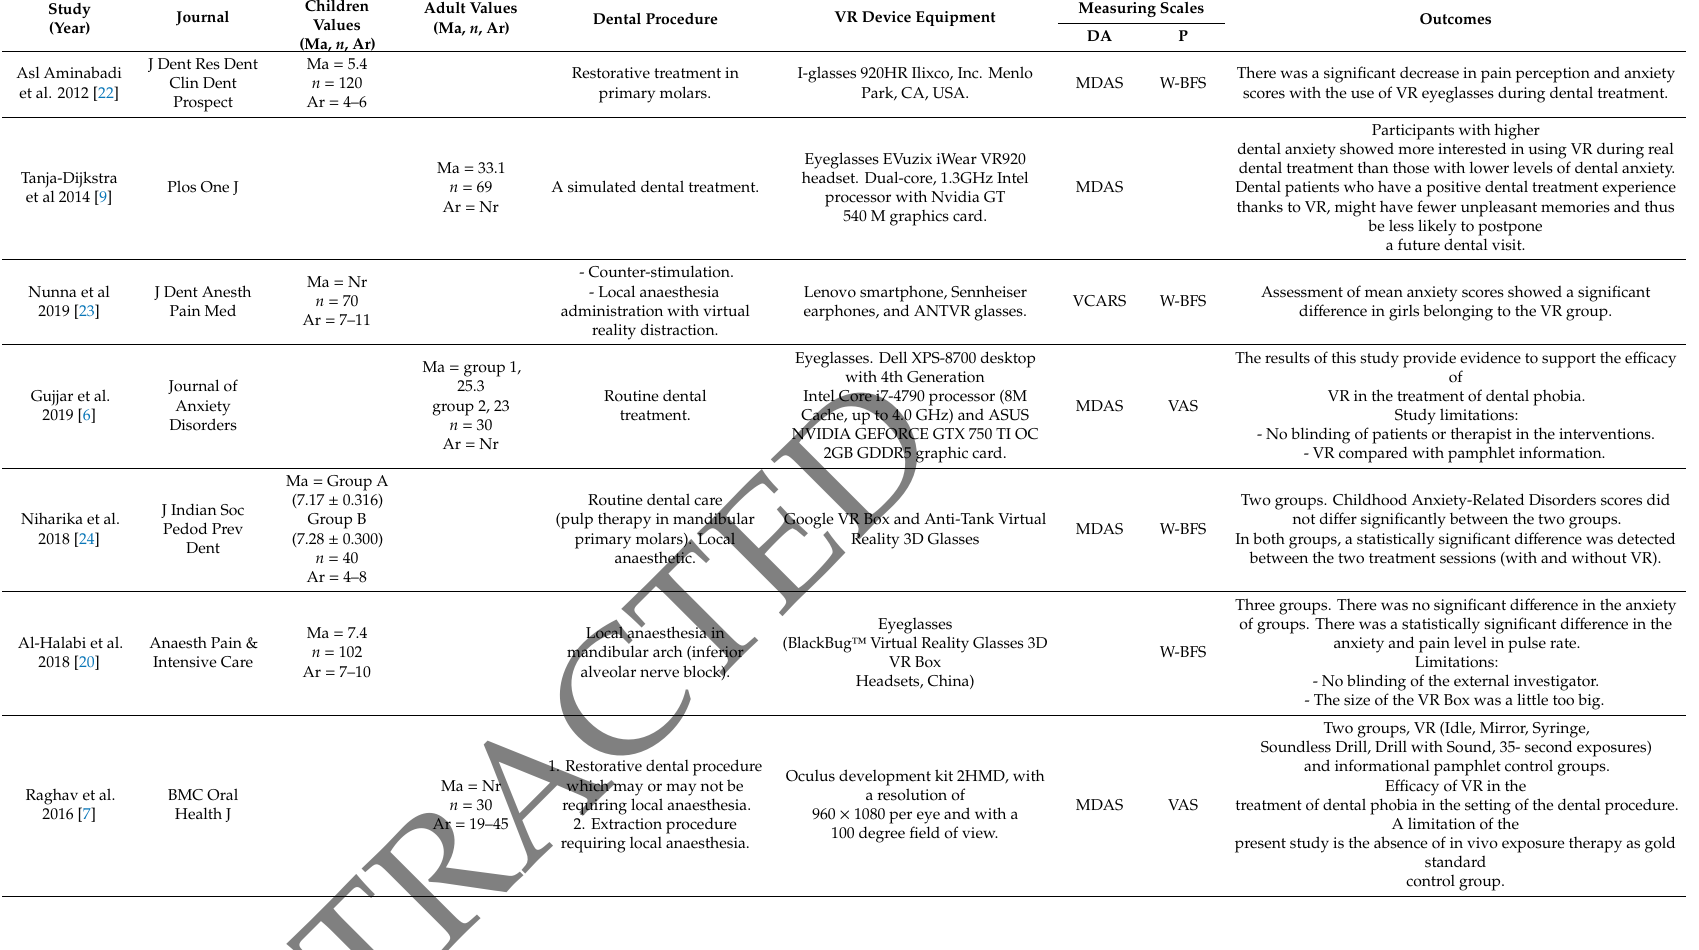
Table 2. Details of each